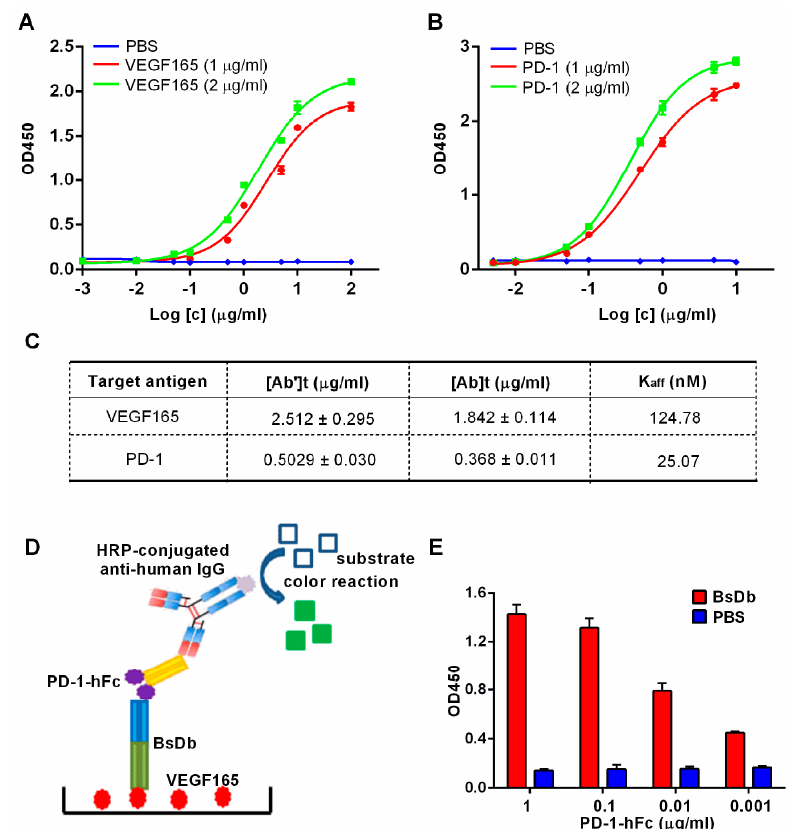
Figure 6. Measurement of affinities of recombinant BsDb to PD-1 and VEGF165. Binding curves of recombinant BsDb to VEGF165 ( A ) and PD-1 ( B ) tested using indirect ELISA. ( C ) The affinity constant was determined using the Beatty formula. [Ab]t and [Ab’]t represent the EC50 of high and low concentrations of antigen, respectively. PBS was used as a negative control. ( D ) Schematic diagram of sandwich ELISA. ( E ) Simultaneous binding of recombinant BsDb to both PD-1 and VEGF165 was evaluated using sandwich ELISA. PBS was used as a negative control. The experiments were performed in triplicate, and the mean values ± SD were presented.